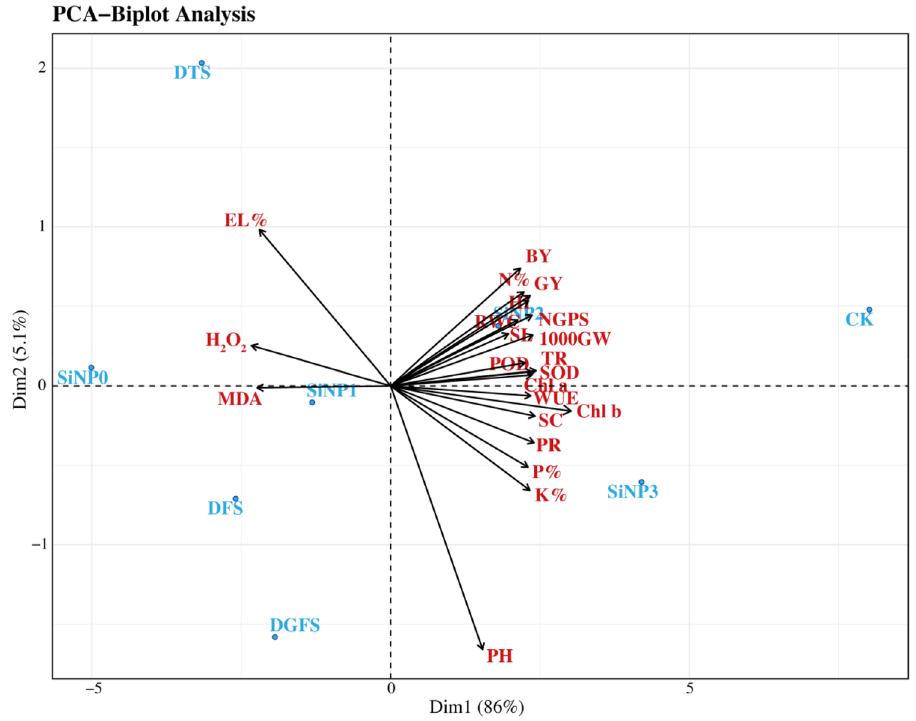
Figure 6. Principal component analysis (PCA) based on morpho-physiological and agronomic parameters of wheat under Si-NPs and drought stress. Plant height (PH, cm), spike length (SL, cm), number of grains per spike (NGPS), 1000-Grain Weight (GW, g), Grain Yield per Plant (GY, g), Biological Yield per Plant (BY, g), Harvesting Index (HI), Chlorophyll a (Chl a), Chlorophyll b (Chl b), Photosynthesis rate (PR), transpiration rate (Tr), Water use efficiency (WUE), stomatal conductance (SC), hydrogen peroxide (H 2 O 2 ), malondialdehyde (MDA), superoxide dismutase (SOD), peroxidase (POD), and Electroleakage percentage (EL%). Application of Si-NPs (0, 300, 600 and 900 mg/L) under drought stress condition at different growth stages CK Control, DTS Drought at tillering stage, DFS drought at flowering stage, and DGFS drought at grain filling